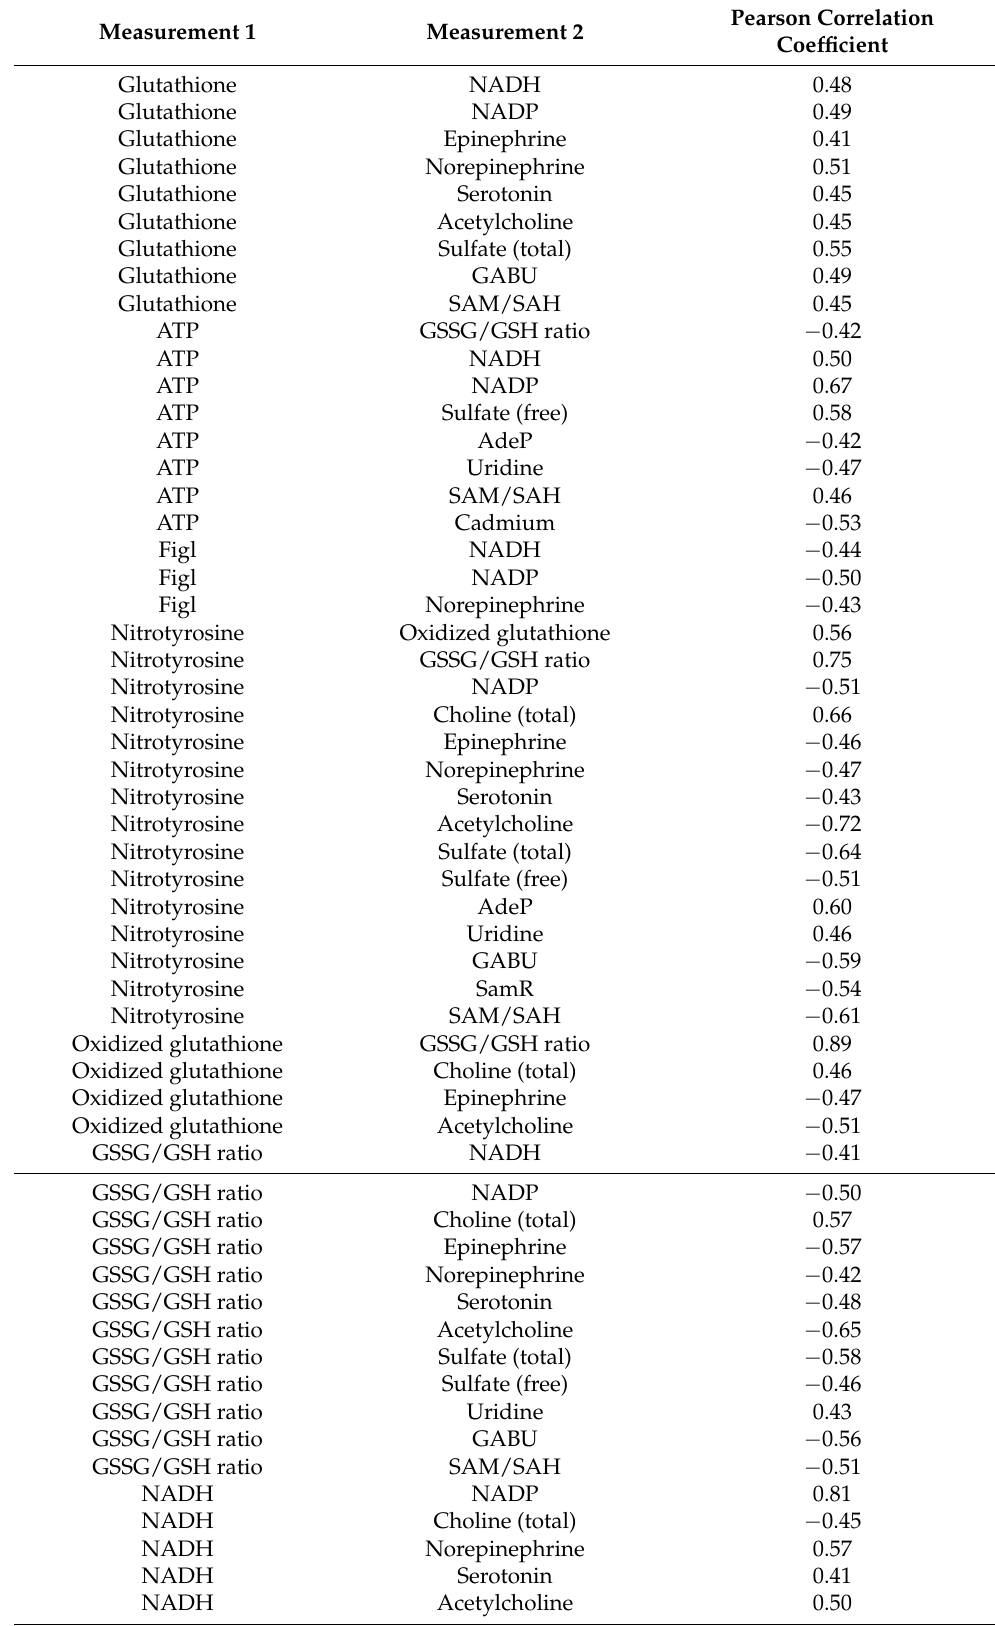
Table A2. Correlations of top metabolites, xenobiotics and elements for the TD group with a Pearson correlation coefficient greater in magnitude than